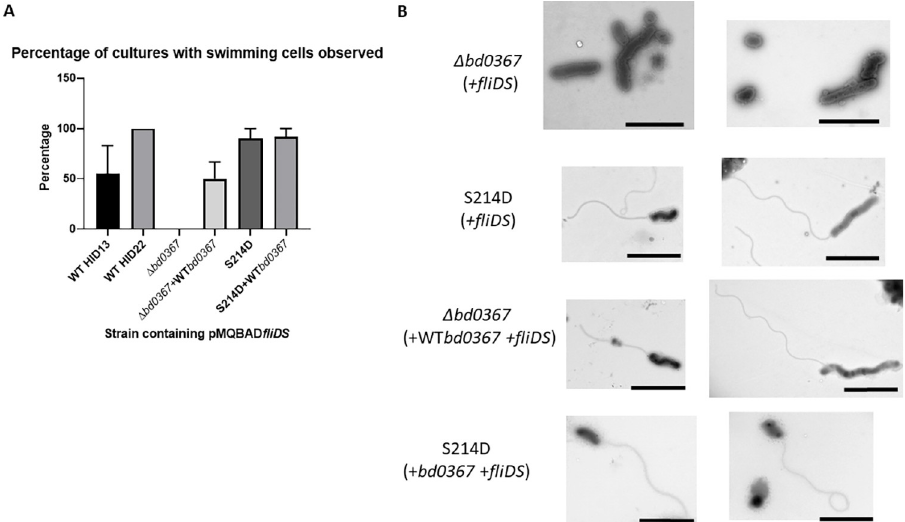
Fig 8. Swimming phenotype of all strains complemented with fliDS in trans . A- Cultures were grown in PY broth supplemented with gentamycin and scored for presence or absence of actively swimming cells. No swimming cells of the Δ bd0367 strain were ever observed, whilst all other strains did exhibit swimming. Data are from 3 biological repeats with cultures grown above OD 600 0.45 per repeat (dependent upon variable growth phenotype of the HI cells and cutoff for this OD 600 chosen as swimming cells were never observed in cultures of OD 600 < 0.45; see Table C in S1 Text for n values). Error bars are SEM. B- Transmission electron micrographs of cells grown after complementation with fliS supplied in trans on a plasmid. No flagella were seen on Δ bd0367 cells, but flagella were seen on cells of the bd0367 (S214D) strain and the strains reconstructed with wild-type bd0367 (when also complemented with fliS ). Cells were stained with 0.5% uranyl acetate for 1 minute on carbon formvar grids and imaged on a FEI Technai bio-twin 12 TEM. Scale bars are 2 μ